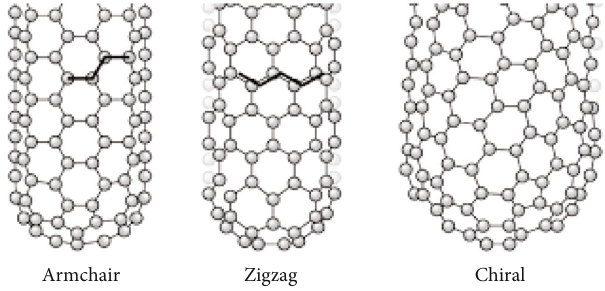
Figure 3: Di ff erent structures of